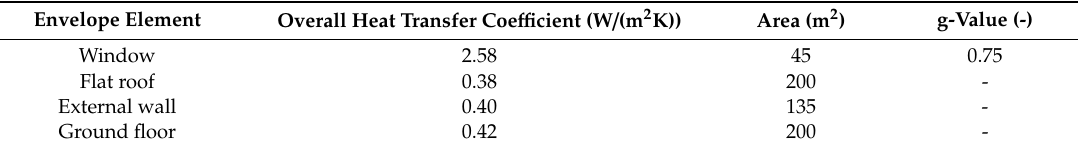
Table 1. O ffi ce building envelope